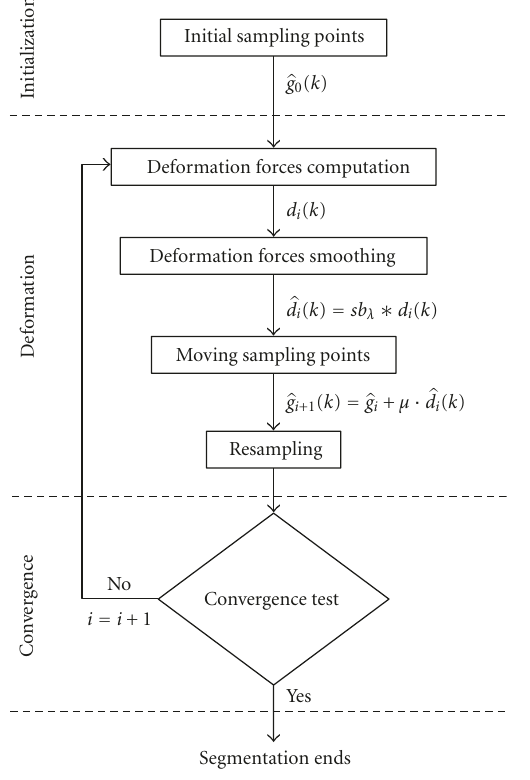
Figure 6: Flow-chart of the locally regularized smoothing B-snake